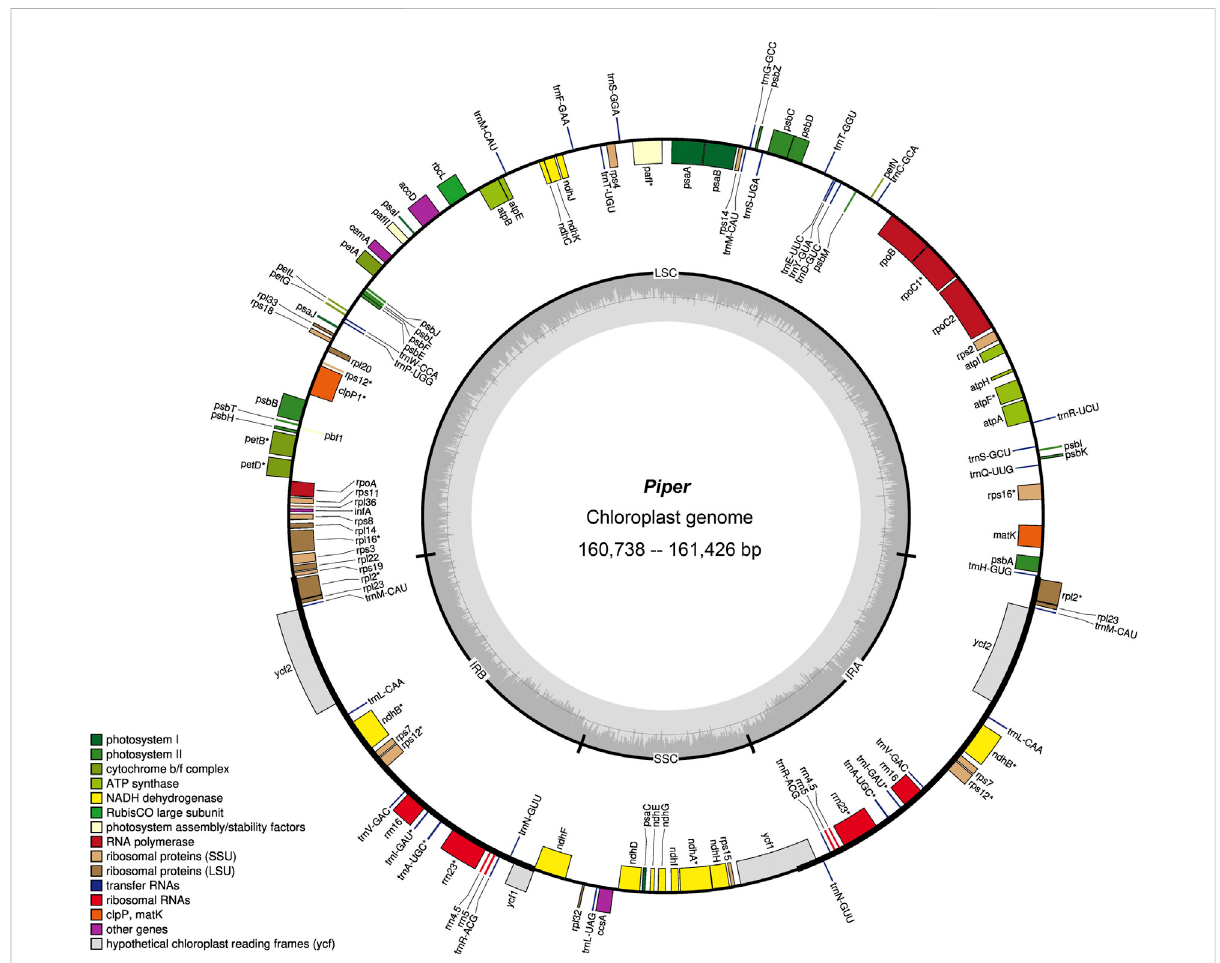
FIGURE 1 Gene map of Piper chloroplast genome. Genes belonging to different functional categories are color-coded. Genes inside the circle are transcribed in a clockwise direction and those located on the outside are transcribed in a counter-clockwise direction. LSC, large-single-copy; SSC, small-single-copy; IR, inverted